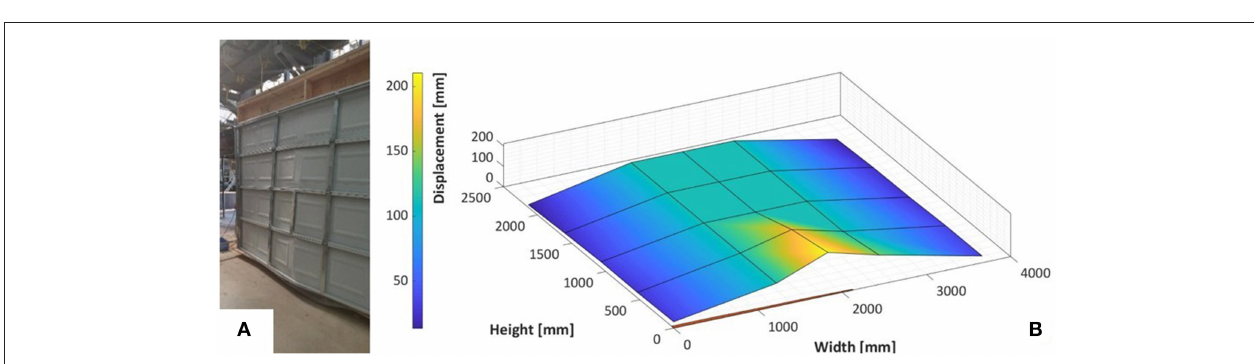
FIGURE 5 | A (A) photograph and the (B) measured displacements of Product 2 (single layer, 25-gauge steel door with U-bar reinforcement) just prior to